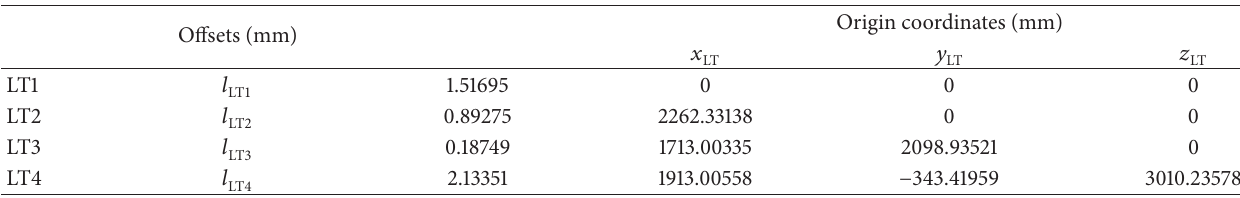
Table 2: Multilaterated offsets and origin coordinates obtained in multilateration reference system. 2798 iterations and objective function value below 1 𝜇 m.